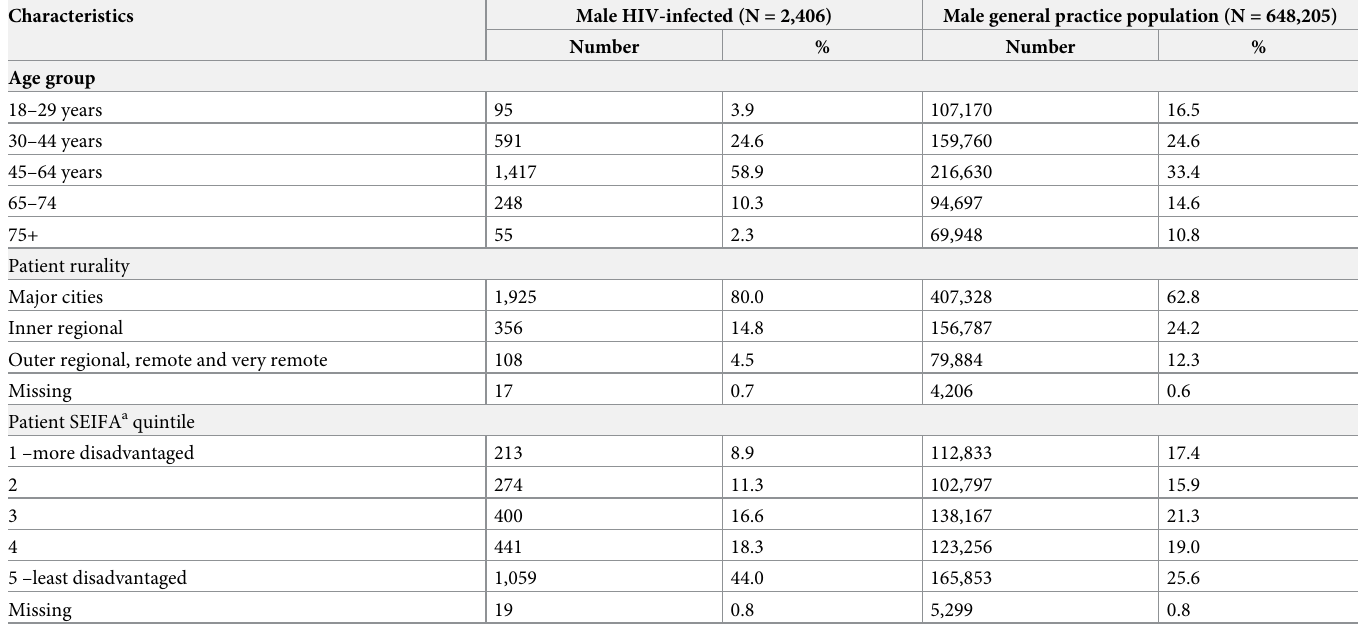
Table 1. Patient socio-demographic characteristics.